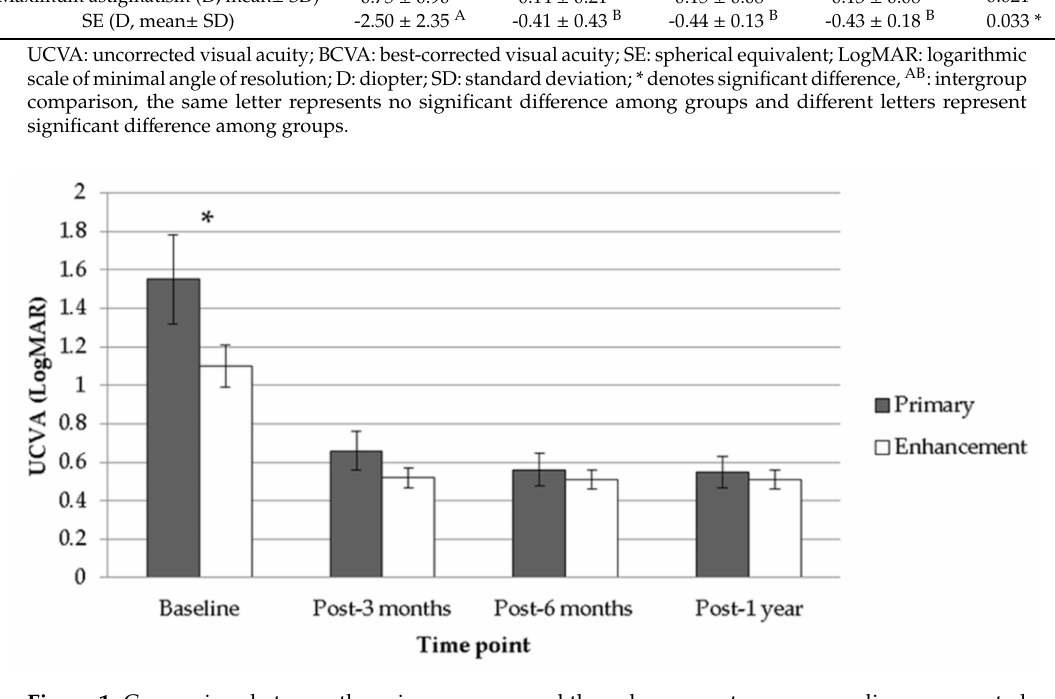
Figure 1. Comparison between the primary group and the enhancement group regarding uncorrected visual acuity. UCVA: uncorrected visual acuity; LogMAR: logarithmic scale of minimal angle of resolution; * denotes significant di ff